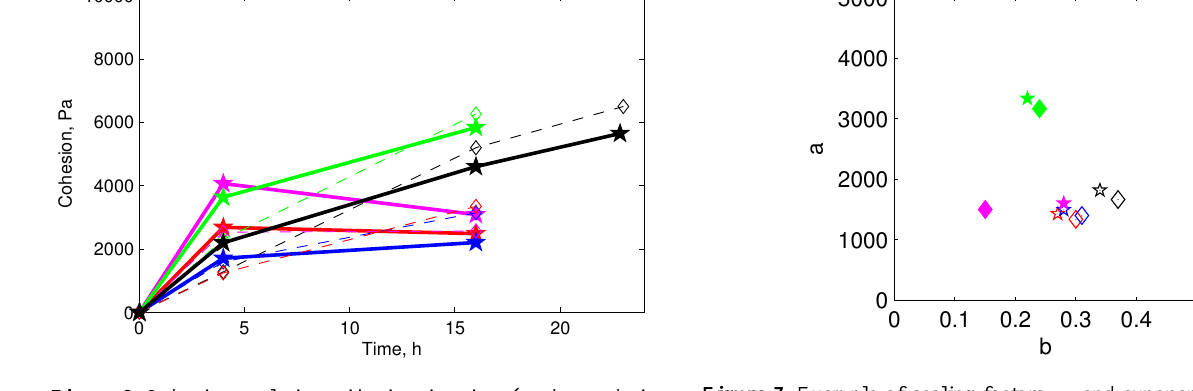
Figure 6. Cohesion evolution with sintering time (marker code is the same as in Fig. 3).